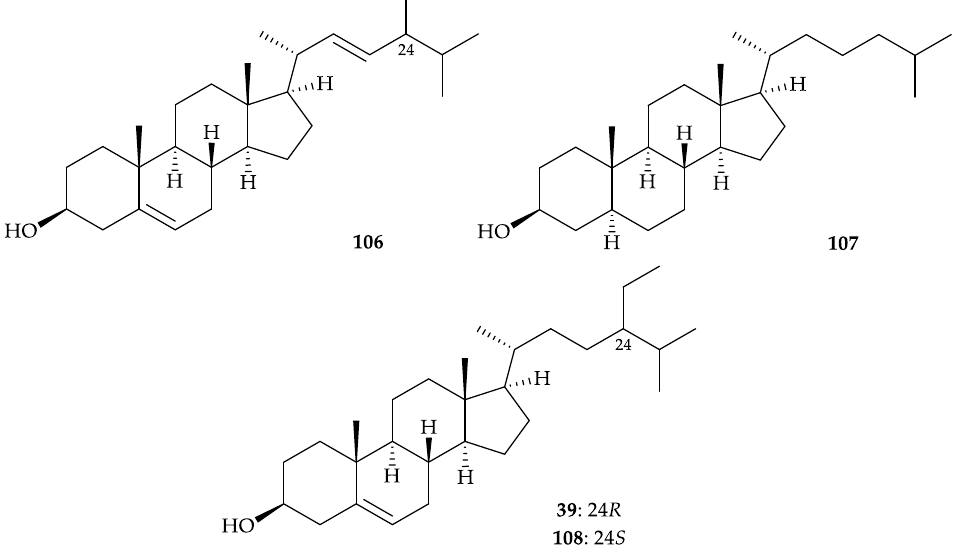
Figure 17. Structures of pincsterol (24 S ), brassicasterol (24 R ) ( 106 ), β-cholestanol ( 107 ), β-sitosterol ( 39 ), and clionasterol ( 108 ).